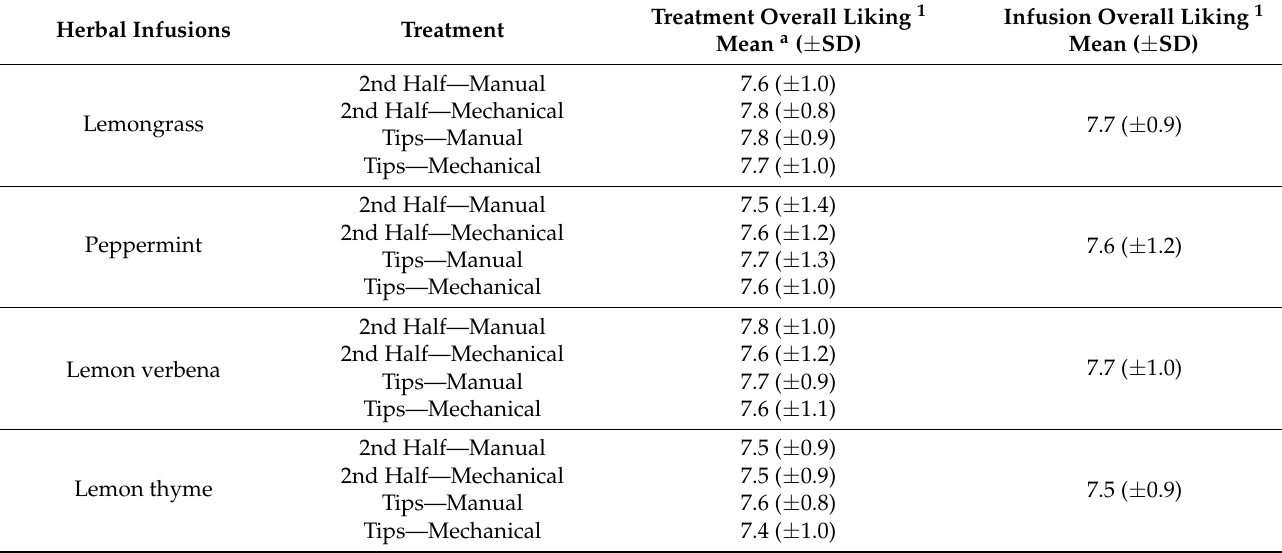
Table 4. Overall liking of the herbal infusions used during experiment II and for each treatment evaluated (plant part and type of